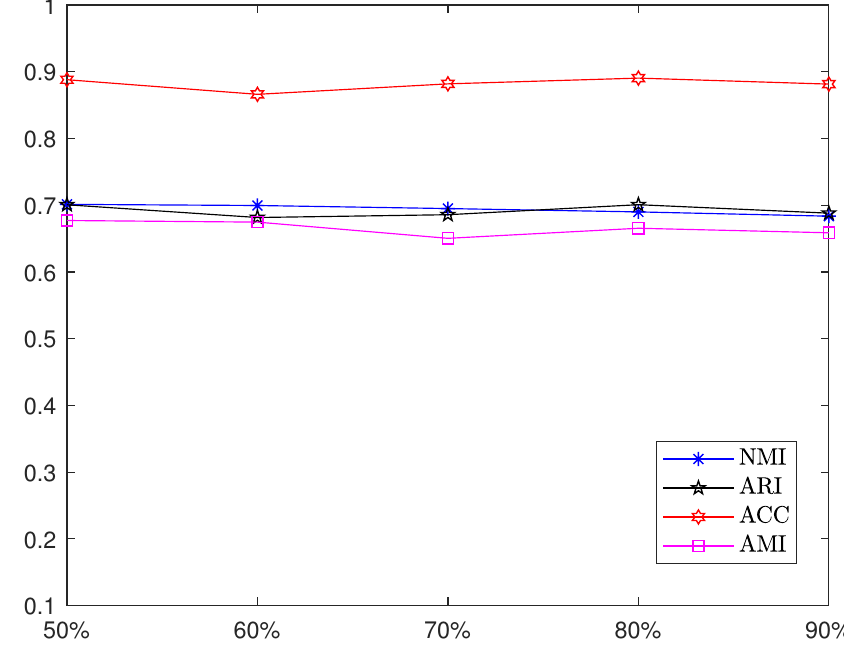
Figure 9. Results of Seeds by